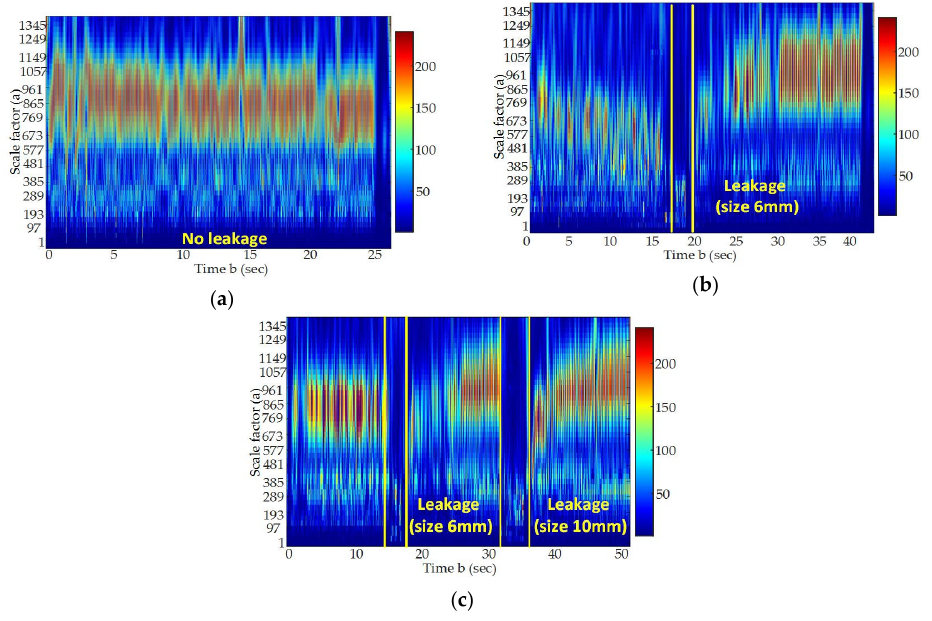
Figure 9. The scalograms of the measured signals with ( a ) no leakage, ( b ) leakage size, 6 mm, and ( c ) leakage size, 6 mm and 10 mm.